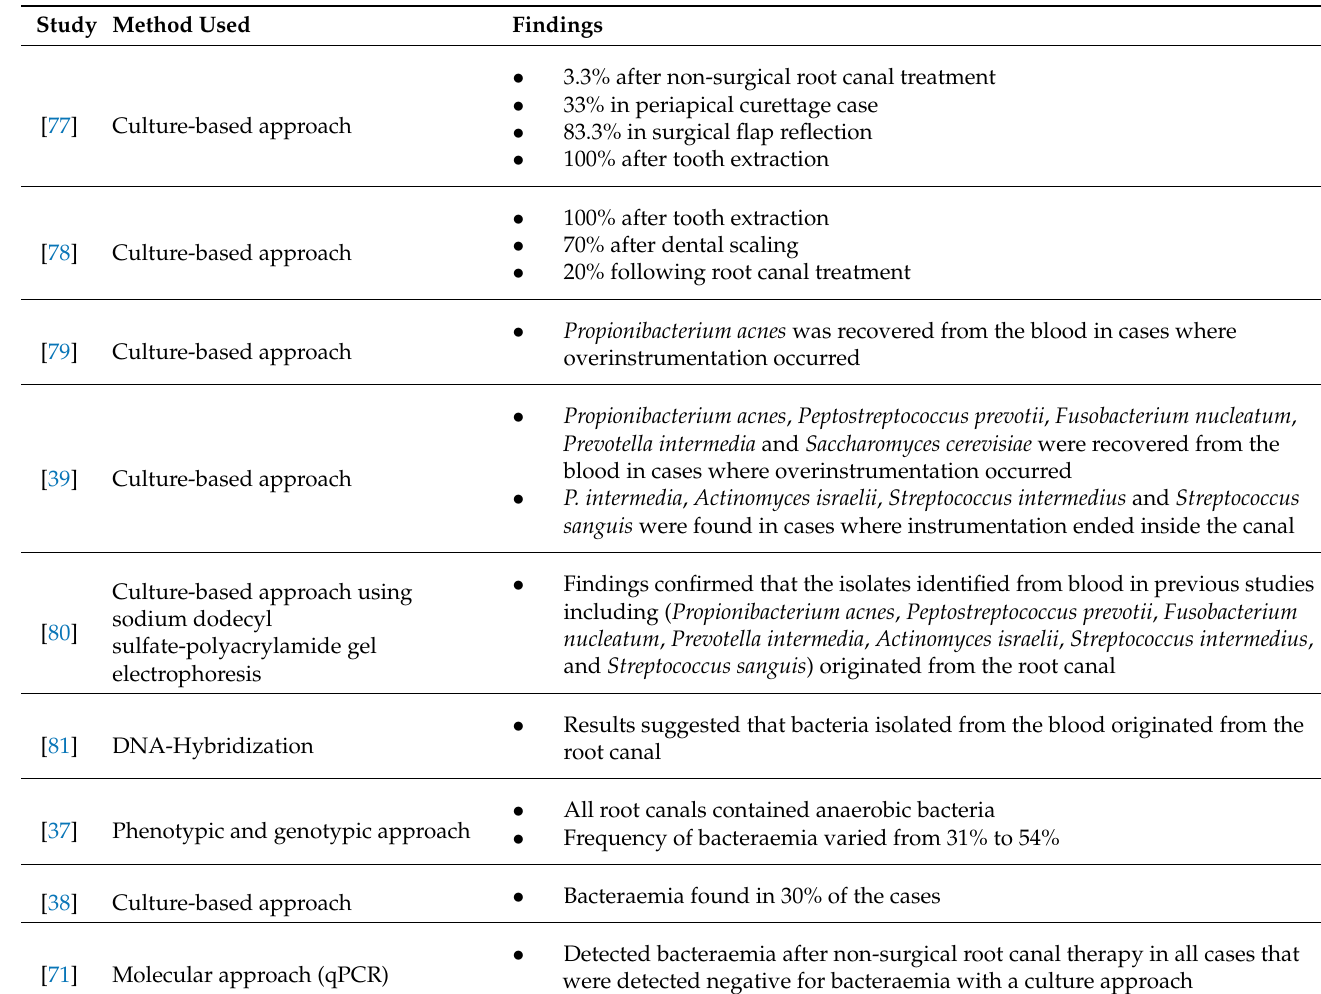
Table 1. Studies investigating bacteraemia associated with endodontic